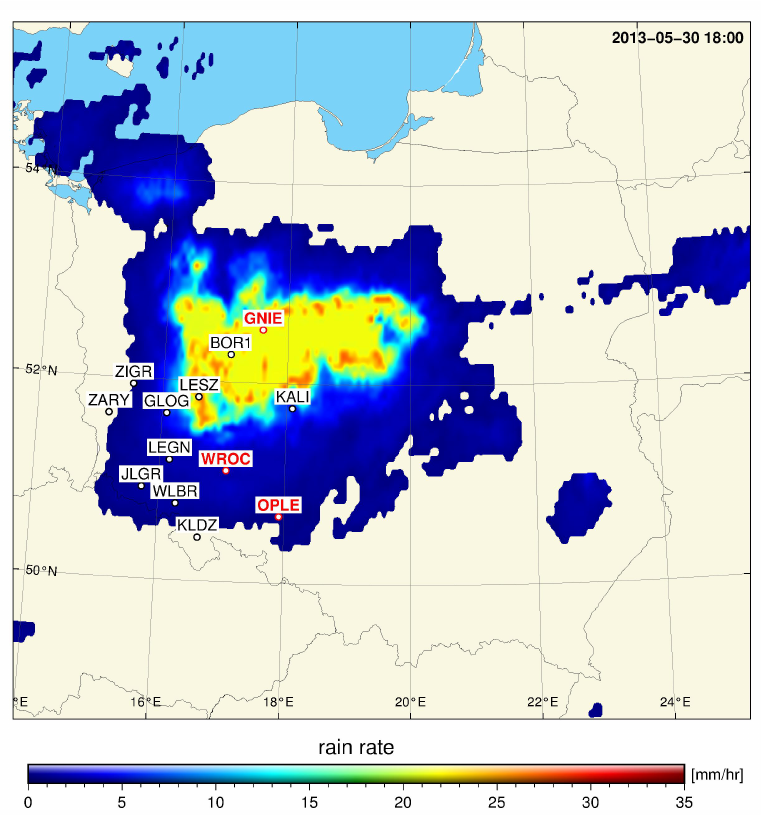
Figure 5. Distribution of GNSS stations used in the analysis on the background of a frontal case (DOY 150) represented by MPE